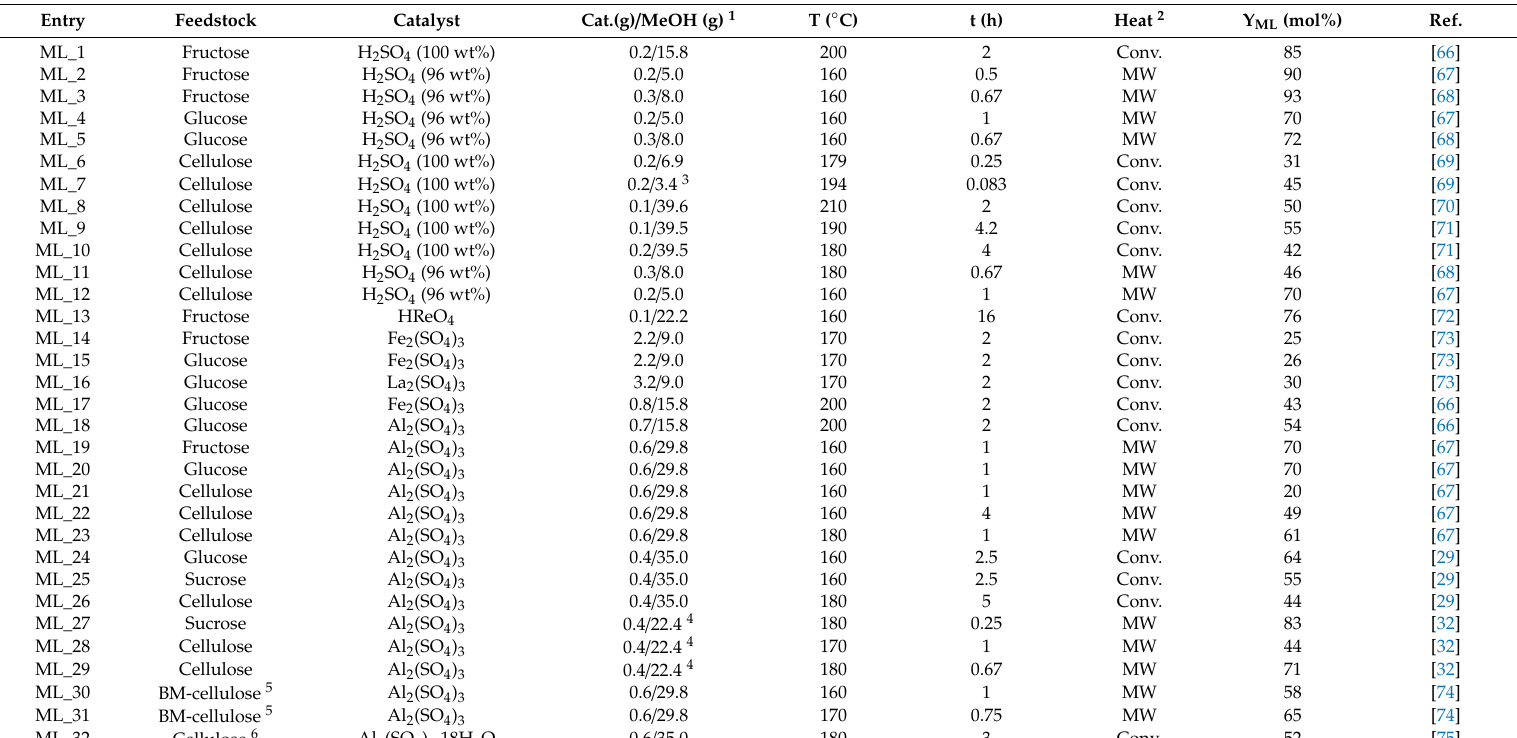
Table 1. Inorganic mineral acids or metal salts for the methyl levulinate (ML) production from C6 model